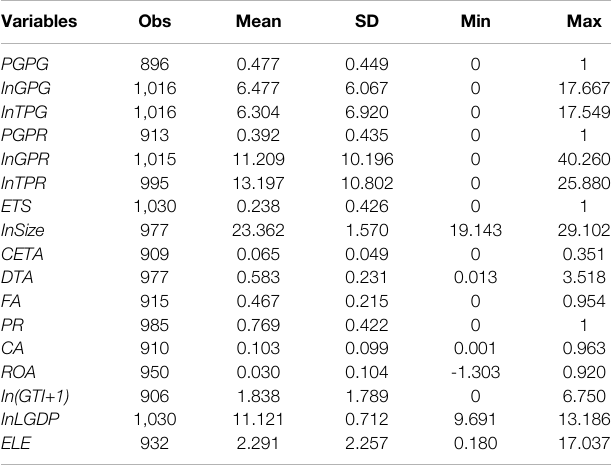
TABLE 2 | The descriptive statistics of main